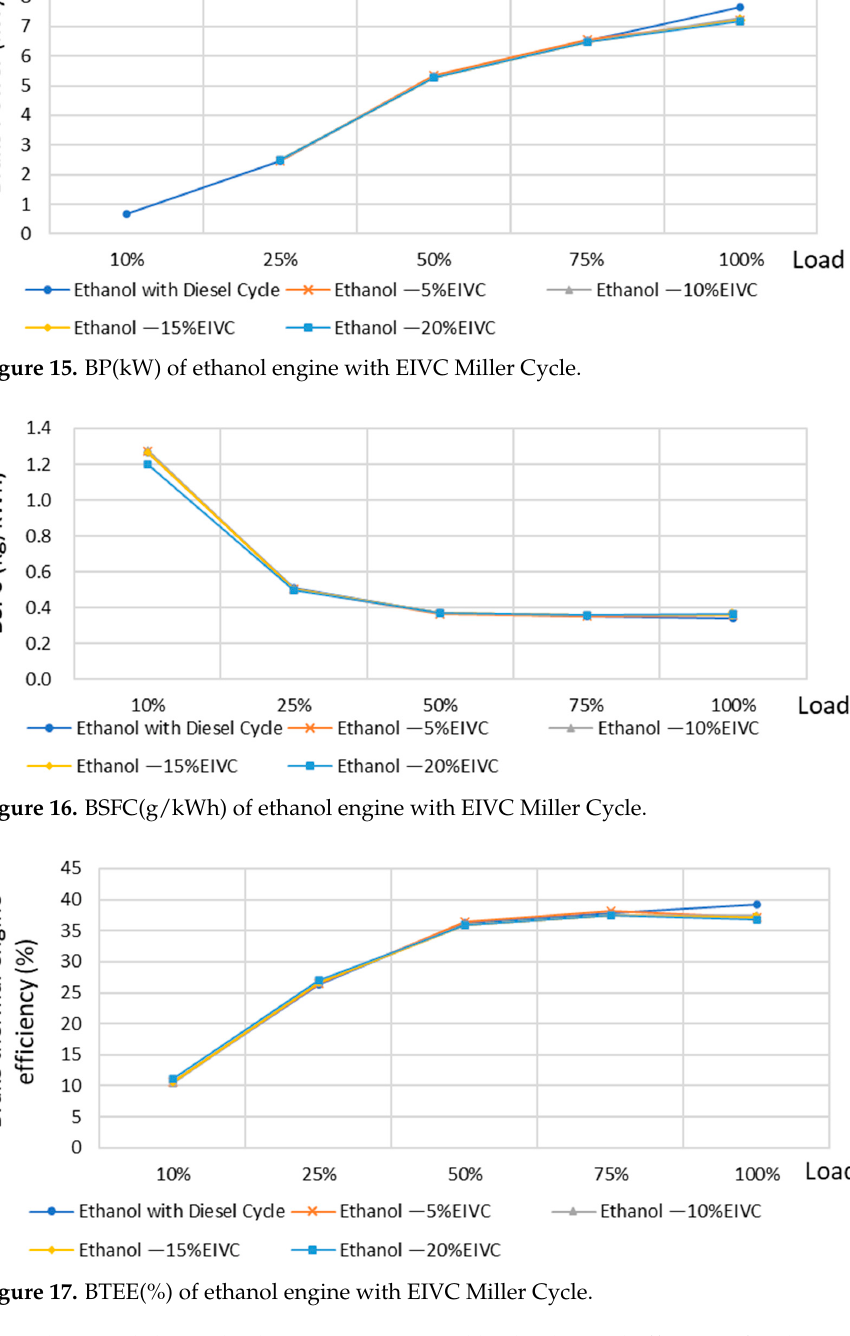
Figure 18. NOx emission(ppm) of ethanol engine with EIVC Miller Cycle.